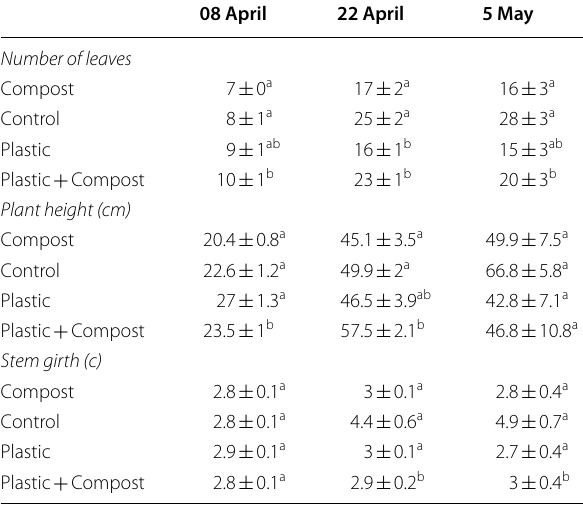
Values are Means Standard Error of the mean. Different superscripts denote a ± significant difference ( p < 0.05) using the Duncan’s multiple range test